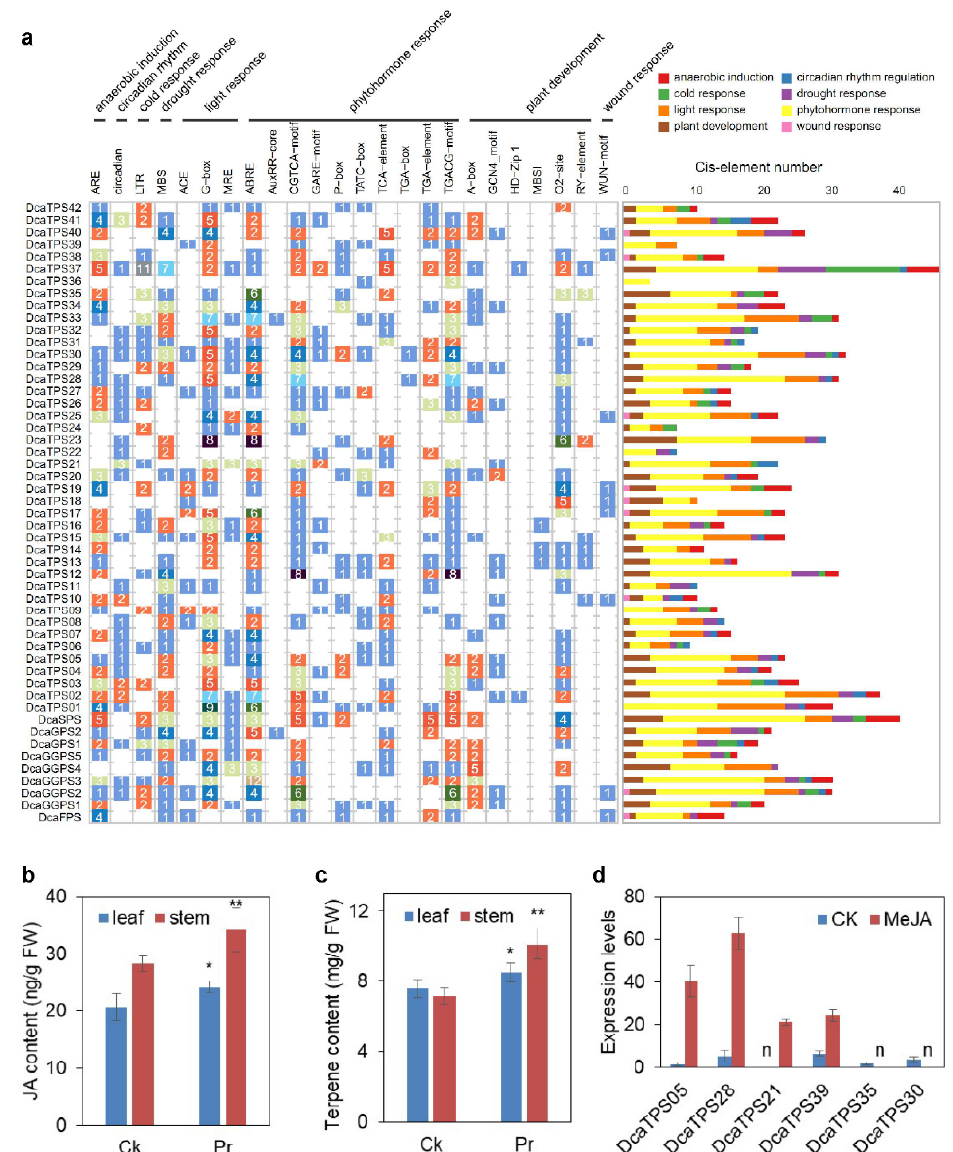
Figure 7. Predicted cis-elements in DcaPS-TPS promoters and the response of DcaPS-TPS under MeJA treatment. ( a ) Promoter sequences ( − 2000 bp) of DcaPS-TPS genes were analyzed by PlantCARE. The classification and number of cis elements were shown on top and left, respectively. ( b ) The endogenous JA content of in Pr and control plants. Values are means ± S.D. ( n = 6). Student’s t -test, * p < 0.05, ** p < 0.01. ( c ) The total terpene content of in Pr and control plants. Values are means ± S.D. ( n = 6). Student’s t -test, * p < 0.05, ** p < 0.01. ( d ) The expression levels of six DcaPS-TPS genes under MeJA treatment. Values are means ± S.D. ( n = 3). n, not detectable.